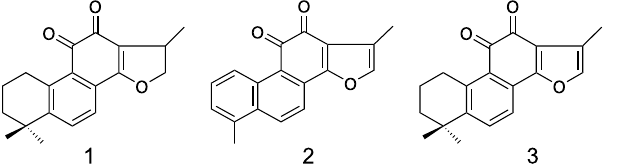
Figure 1. Structural formulas of cryptotanshinone (1), tanshinone I (2) and tanshinone IIA (3).